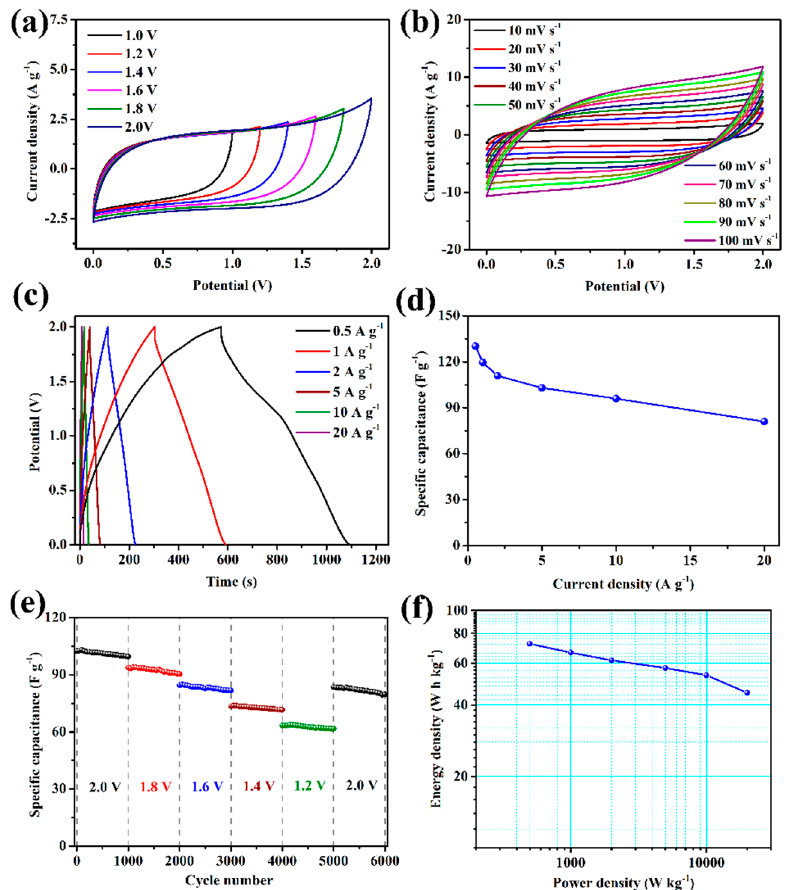
Figure 8. CV curves of MPC//FPC ASC device in different potential windows at a scan rate of 20 mV s − 1 ( a ) and CV curves of the device at different scan rates ( b ). GCD curves of the device at different current densities ( c ) and specific capacitance calculated from these GCD curves ( d ). Cycling durability test of the device in different potential windows ( e ) and the Ragone plot of the device ( f ).